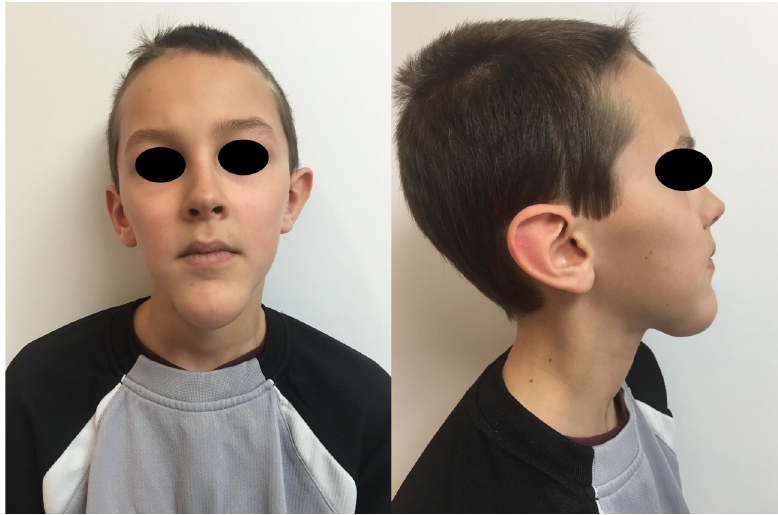
Fig. 1. Front and pro fi le preoperative photographs showing the chin deformation.